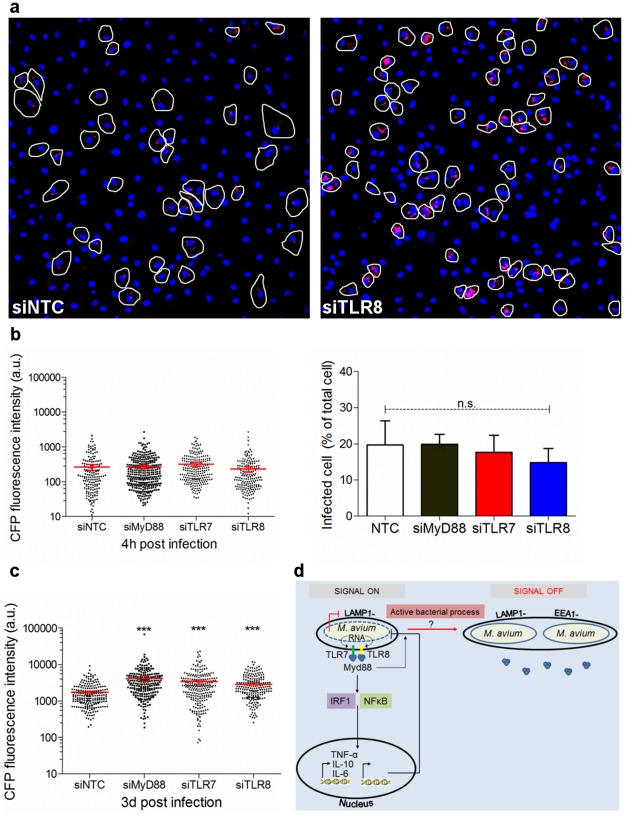
TLR7/8/MyD88 regulate intracellular growth of Mav in human primary macrophages.Human MDMs were treated with siRNA against MyD88, TLR7, TLR8 or a non-targeting control before infection with Mav-CFP (10 min uptake followed by 4h to 3d chase). (A) Representative images where infected cells treated with siNTC (left) or siTLR8 (right) are outlined for analysis (Mav-CFP: red, nuclei: blue (Hoechst)). (B, C) In situ quantification of Mav-CFP 4 hours (B) and 3 days (C) post infection using the Corrected Total Cell Fluorescence method on infected cells. Quantification scatter plots show individual cell measures with mean +/- 95% confident intervals from 3 donors ((B, C) left graphs, n>250 cells per time point and per donor). The bar chart in (B) shows the percentage of infected cells 4 hours post infection to compare uptake. (D) Working model. Mav (dashed line, blue) is processed in LAMP1+ phagolysosomes. Release of mycobacterial nucleic acids engages TLR7/8, recruitment of MyD88 to the compartment, and inflammatory signaling culminating in cytokine release and growth restriction. A fraction of live Mav actively remodels the phagolysosome and/or is sorted into a new compartment (MavC) where late endosomal/lysosomal markers are excluded, TLR7/8 are not engaged and MyD88 is not recruited, thus avoiding inflammatory signaling and destruction. The program leading to Mav destruction (red line) remains to be elucidated.